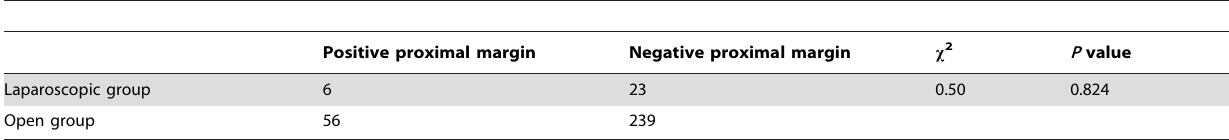
Table 5. Incidence of positive proximal margin between laparoscopic group and open group among patients undergoing transabdominal procedures in terms of Type II and III